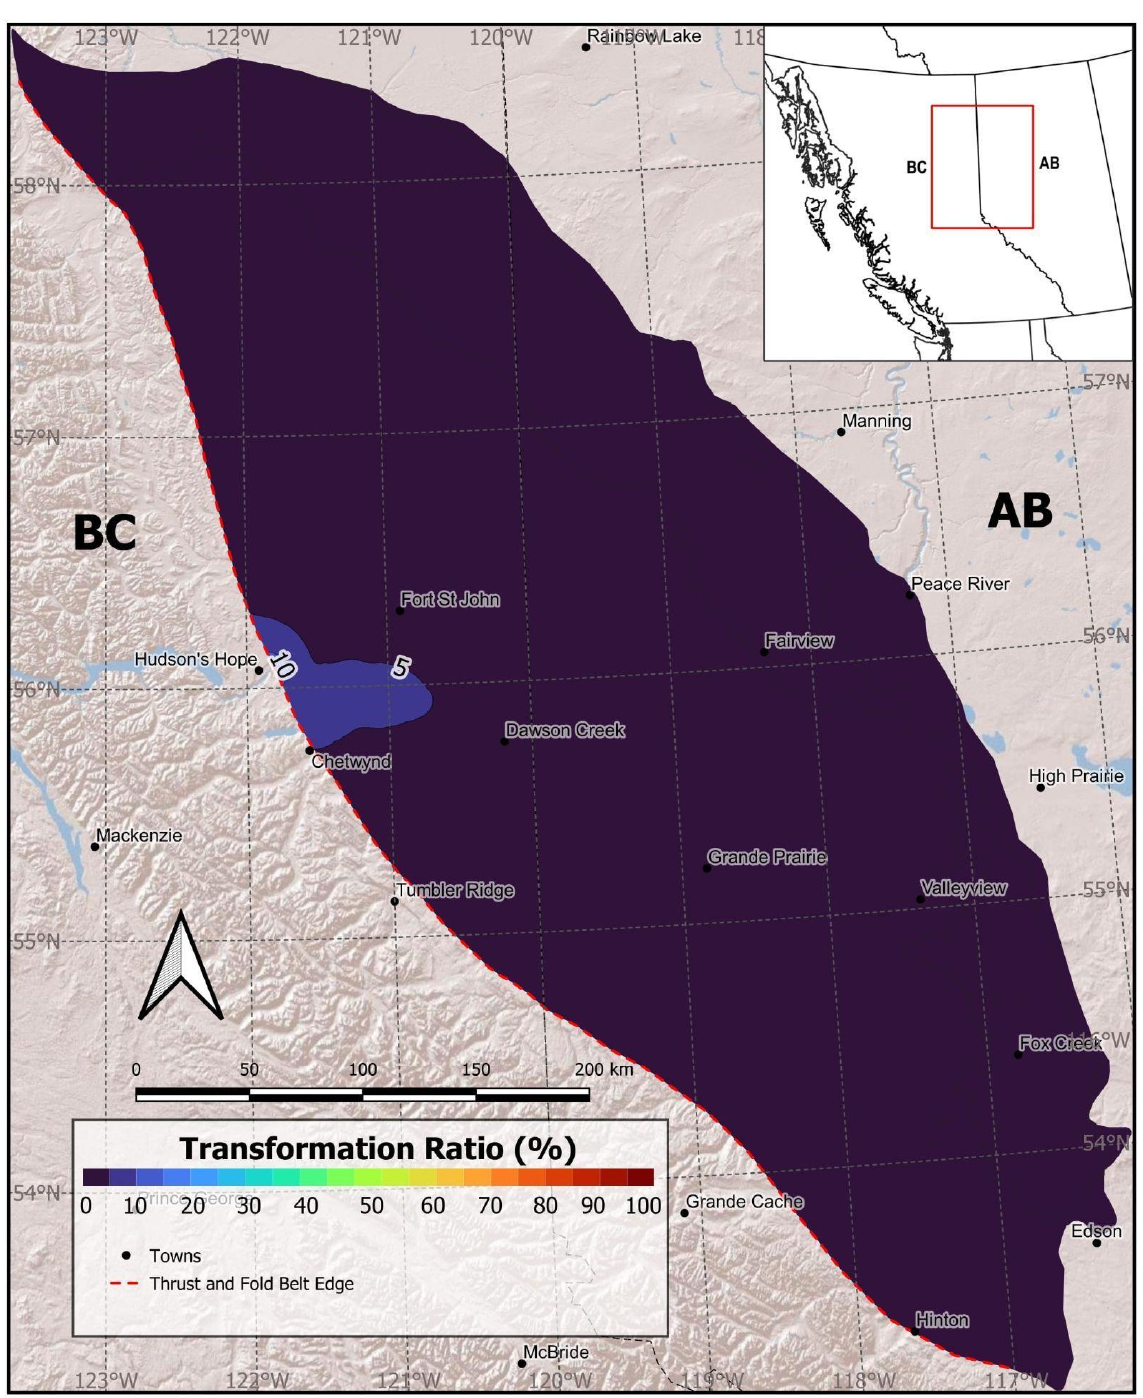
Figure 19. Kerogen transformation ratio in the Middle Montney Formation at 101 Ma. This was the initial generation of hydrocarbons in the Montney Formation.